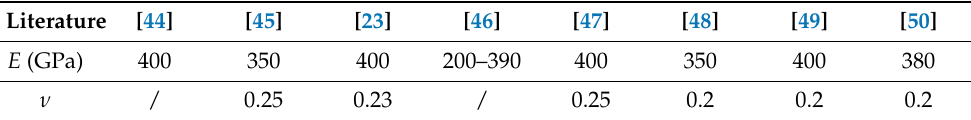
Table 4. The elastic constants of TGO in the literature.